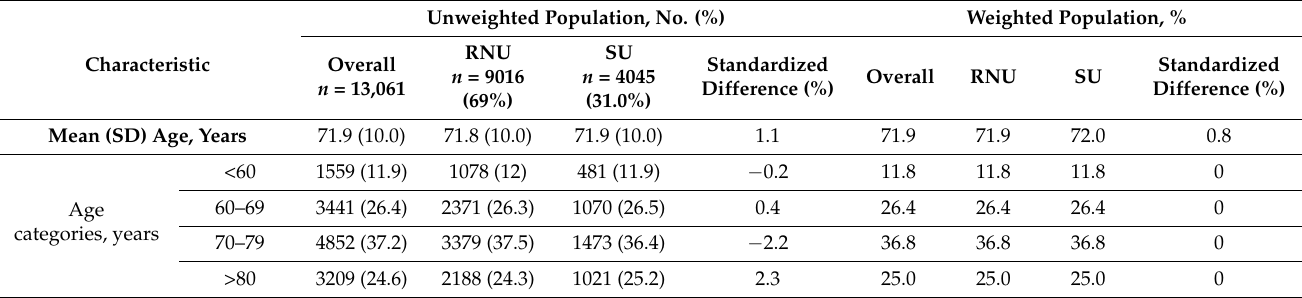
Figure 1. Flowchart that describes the selection of patients who received Radical Nephroureterectomy with bladder cuff excision (RNU) versus patients who received Segmental Ureterectomy (SU) for localized urothelial carcinoma of the ureter in the National Cancer Database, 2004 to 2015. Table 1. Baseline characteristics of patients treated with Radical Nephroureterectomy with bladder cuff vs. Segmental Ureterectomy for localized ureteral carcinoma in unweighted and weighted